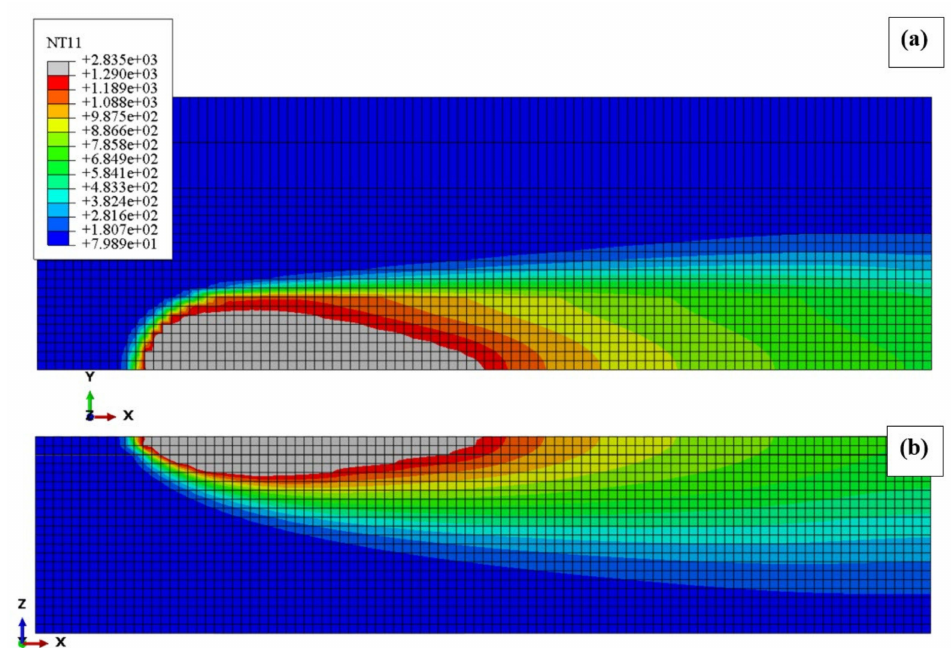
Figure 7. Predicted temperature contours ( a ) top view ( b ) front view.